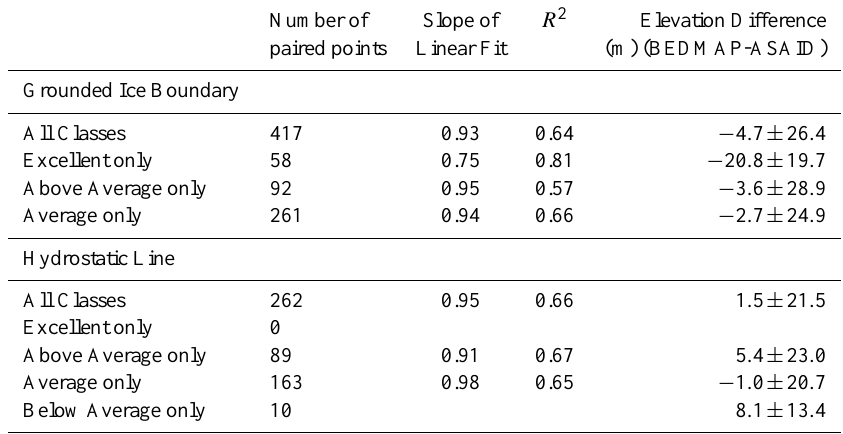
Table 4. Comparison of BEDMAP and ASAID Surface Elevations. Slope and R 2 values refer to linear fits forced to pass through (0, 0) (cf., Fig.